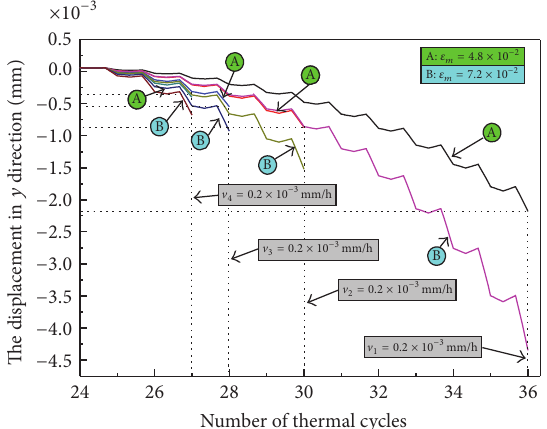
Figure 5: The plot of displacement in 𝑦 direction for node number 517 at the base of the surface groove against the number of thermal cycles when 𝜀 𝑚 = 4.8 × 10 −2 , 𝜀 𝑚 = 7.2 × 10 −2 .